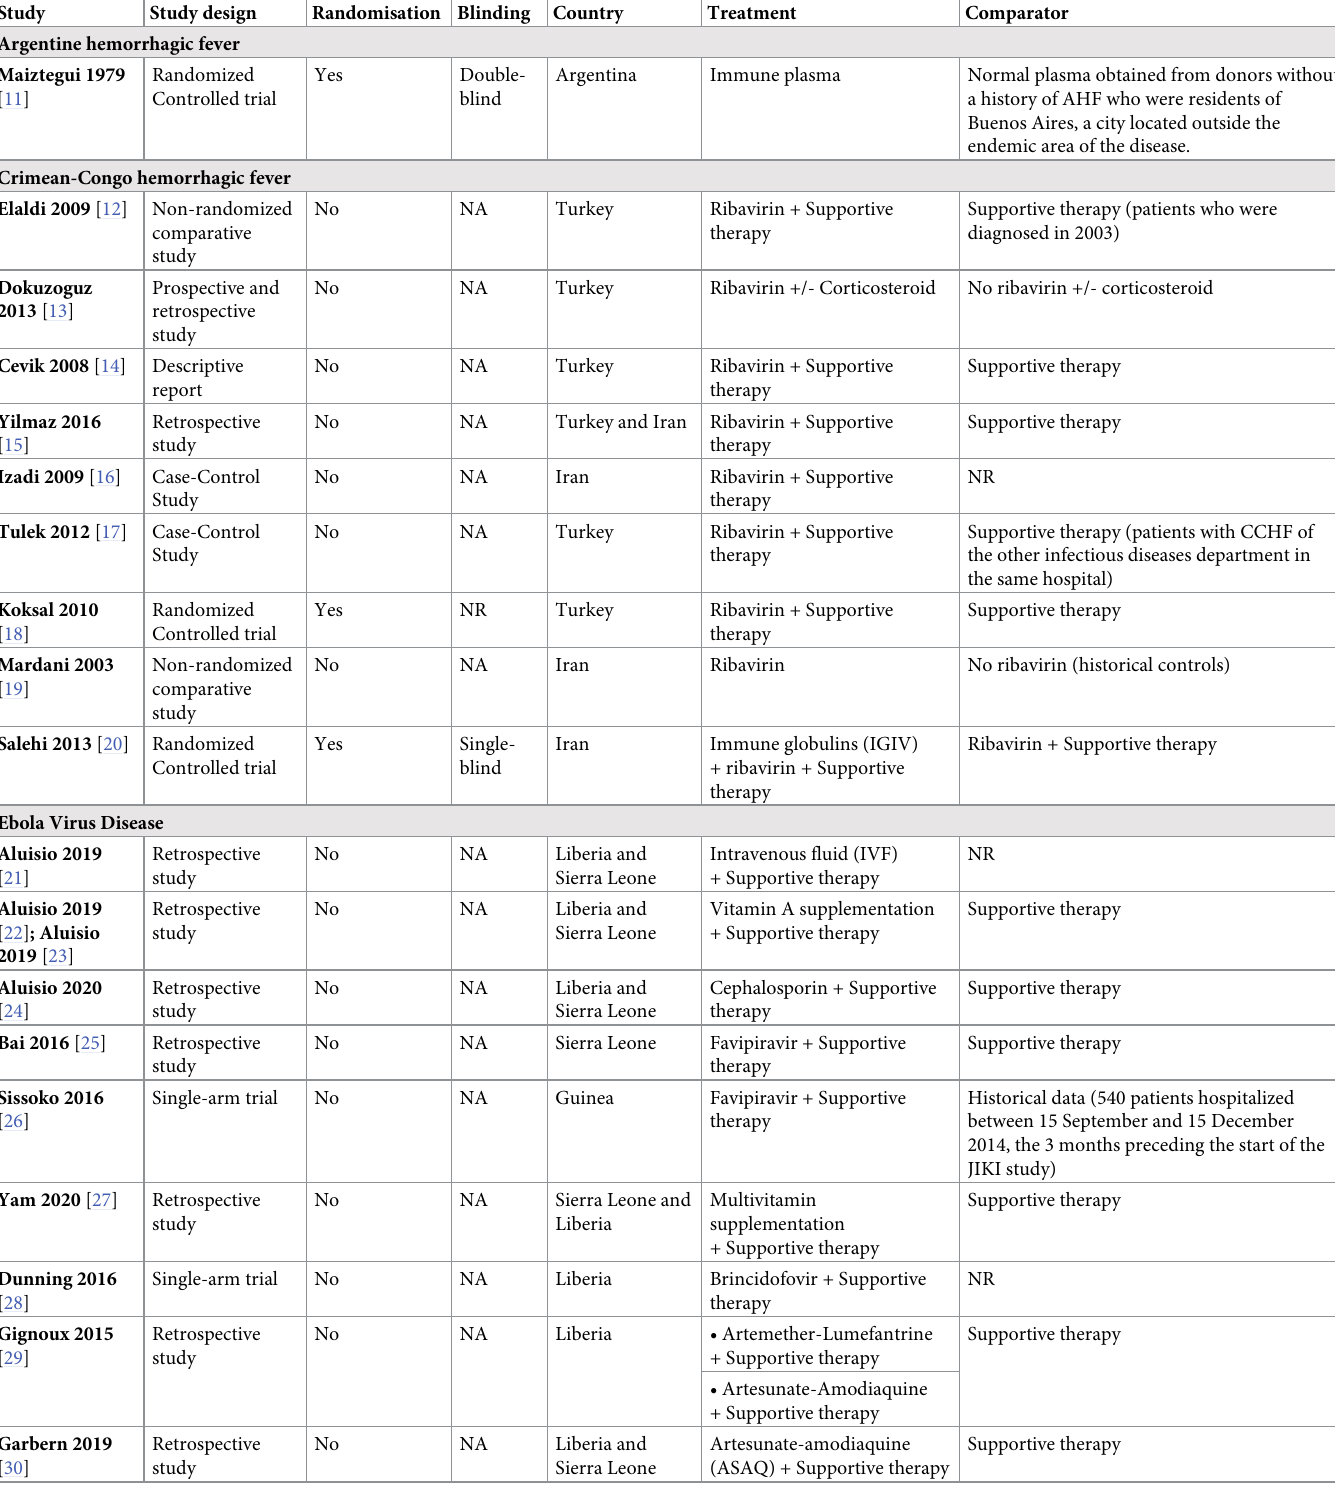
Table 2. Characteristics of included studies reporting results on treatments by